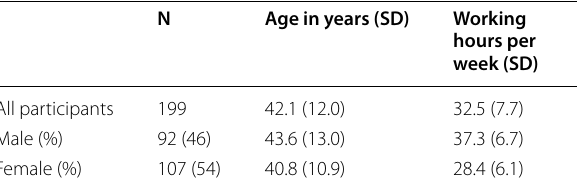
Table 1 Characteristics of the physiotherapists participating